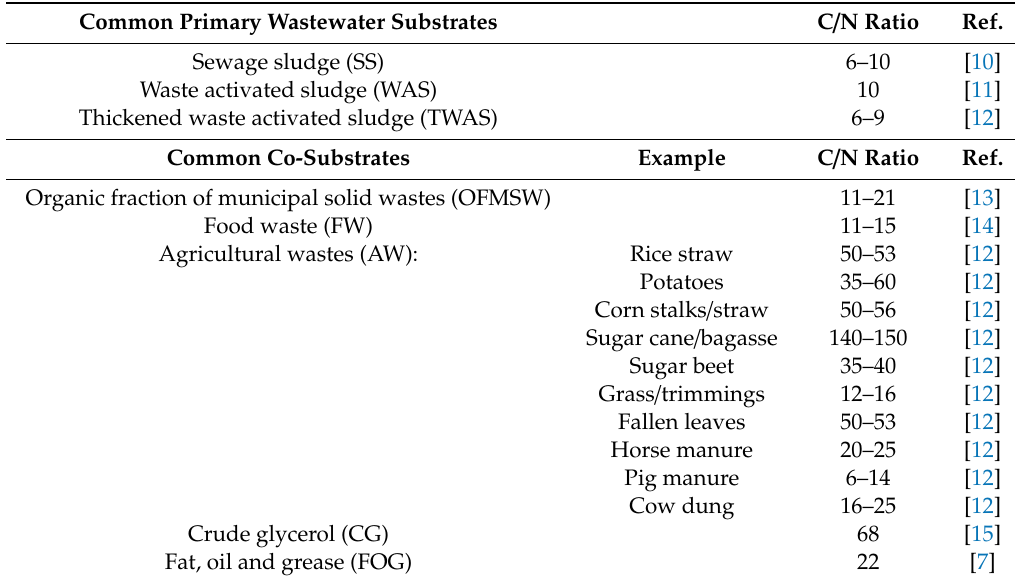
Table 1. Carbon-to-nitrogen (C / N) ratio of the primary and co-substrates reviewed in this study. Common Primary Wastewater Substrates C / N Ratio Ref. Sewage sludge (SS) 6–10 Waste activated sludge (WAS) Thickened waste activated sludge (TWAS) Common Co-Substrates Example C / N Ratio Ref. Organic fraction of municipal solid wastes (OFMSW) Food waste